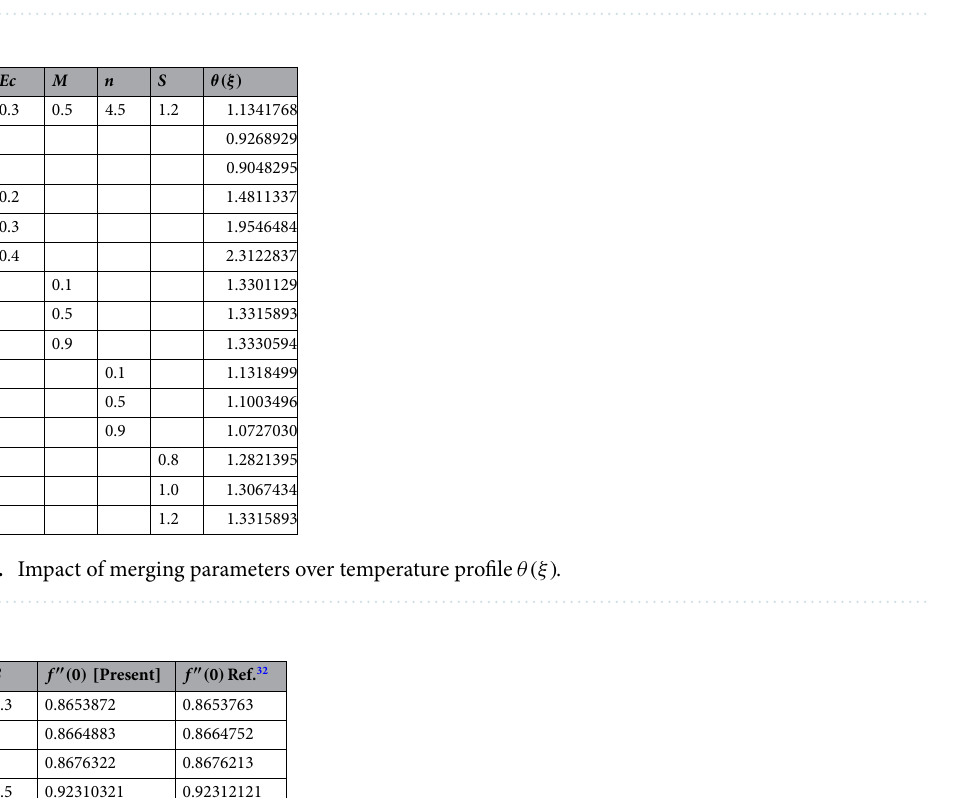
Table 1. Impact of various emerging parameters upon flow profile f (ξ) .